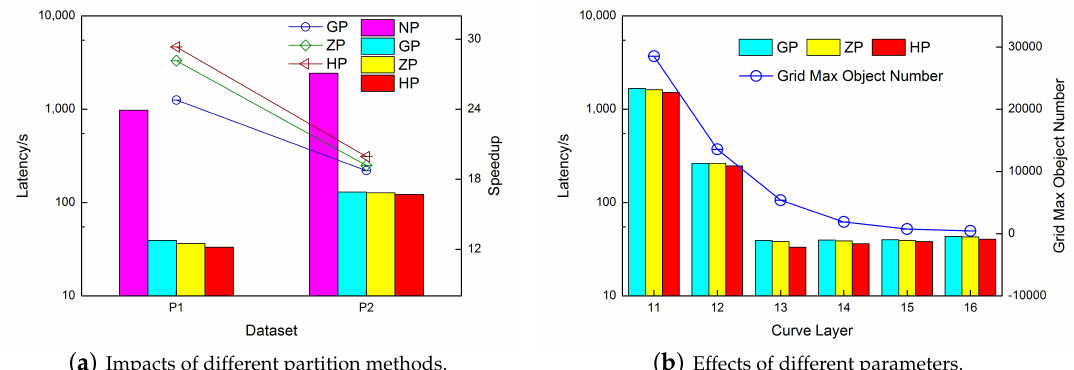
Figure 8. Experiment on cross-grid data processing methods.